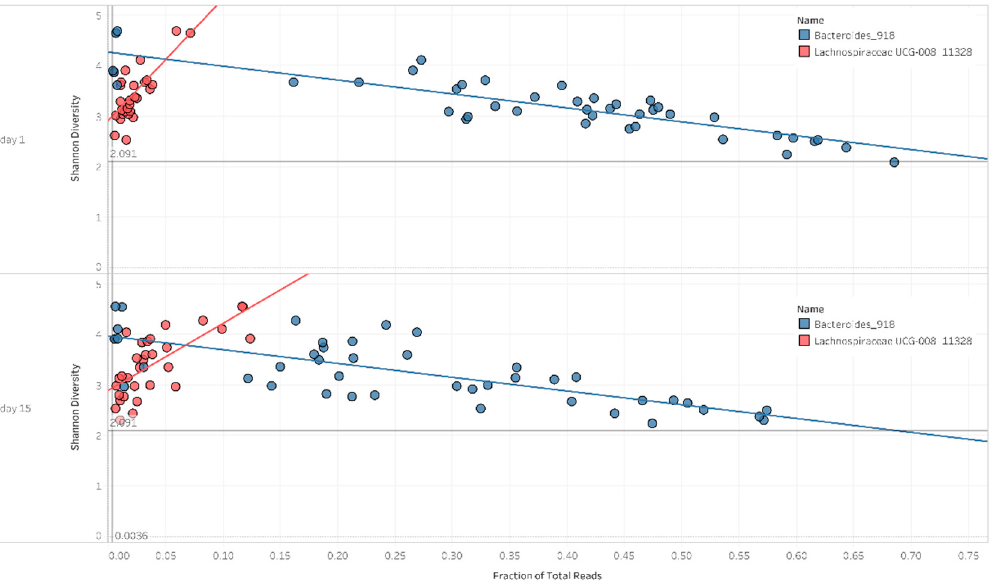
Figure 5. Scatter plot for Shannon diversity and bacterial abundance on day 1 and day 15. The figures present a positive and negative correlation between the Shannon diversity and the abundance of Bacteroides and Lachnospiraceae UCG-008, as well as the fitted trend lines.